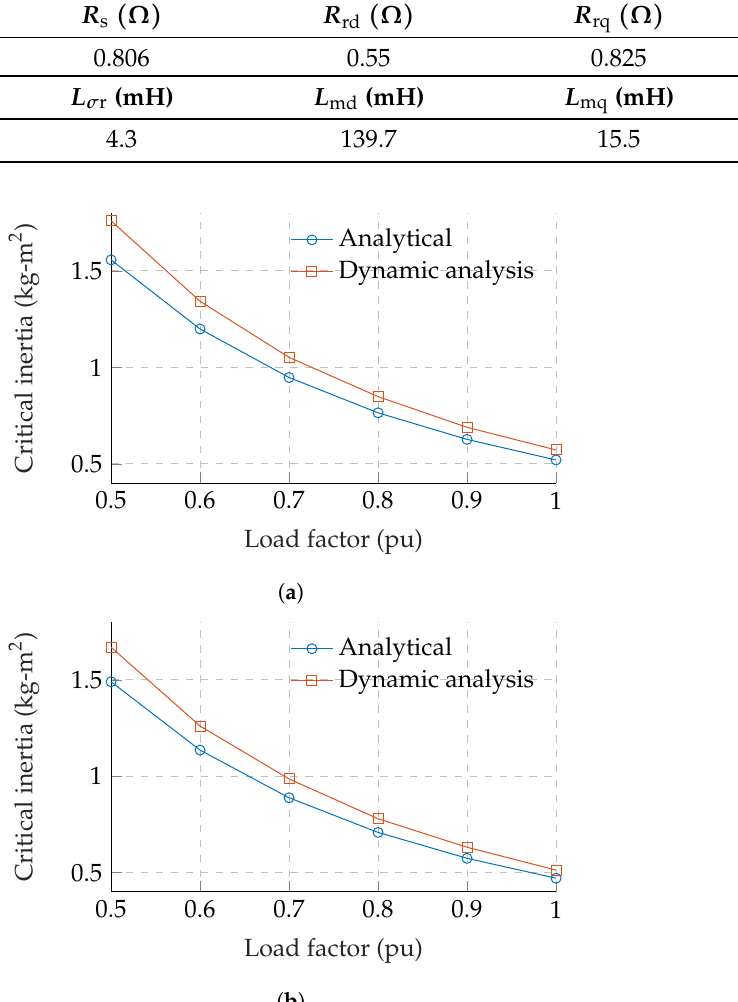
Figure 4. Comparison of the calculated critical inertia for ( a ) constant load and ( b ) load quadratic with rotor